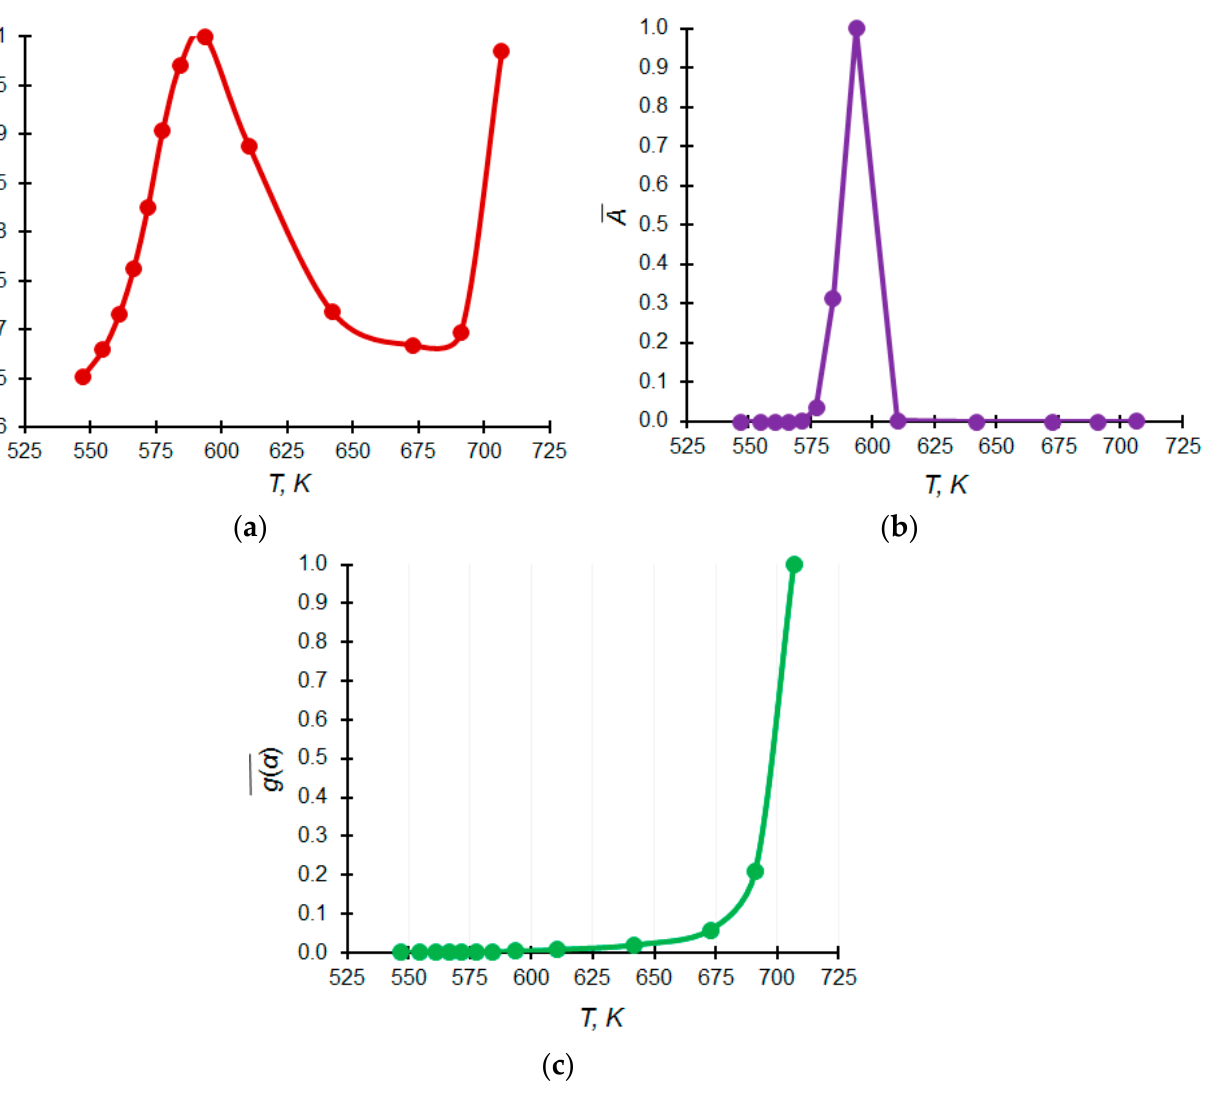
Figure 5. Normalized kinetic parameters: ( a ) activation energy; ( b ) pre-exponential factor; ( c ) algebraic function g( α ).